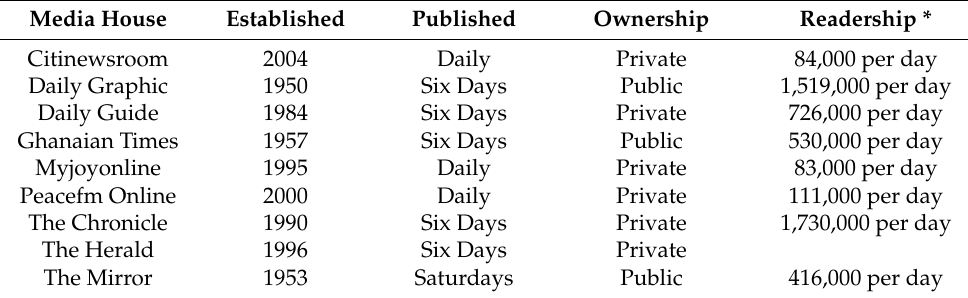
avoid duplication, we did not include articles featured on the Daily Graphic online. Table 1. Selected Media Houses in